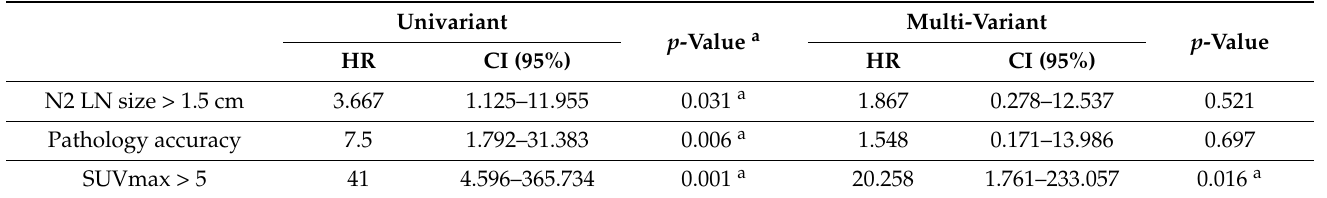
Table 2. Univariate and multivariate logistic regression of predictors for diagnostic accuracy of ROSE.